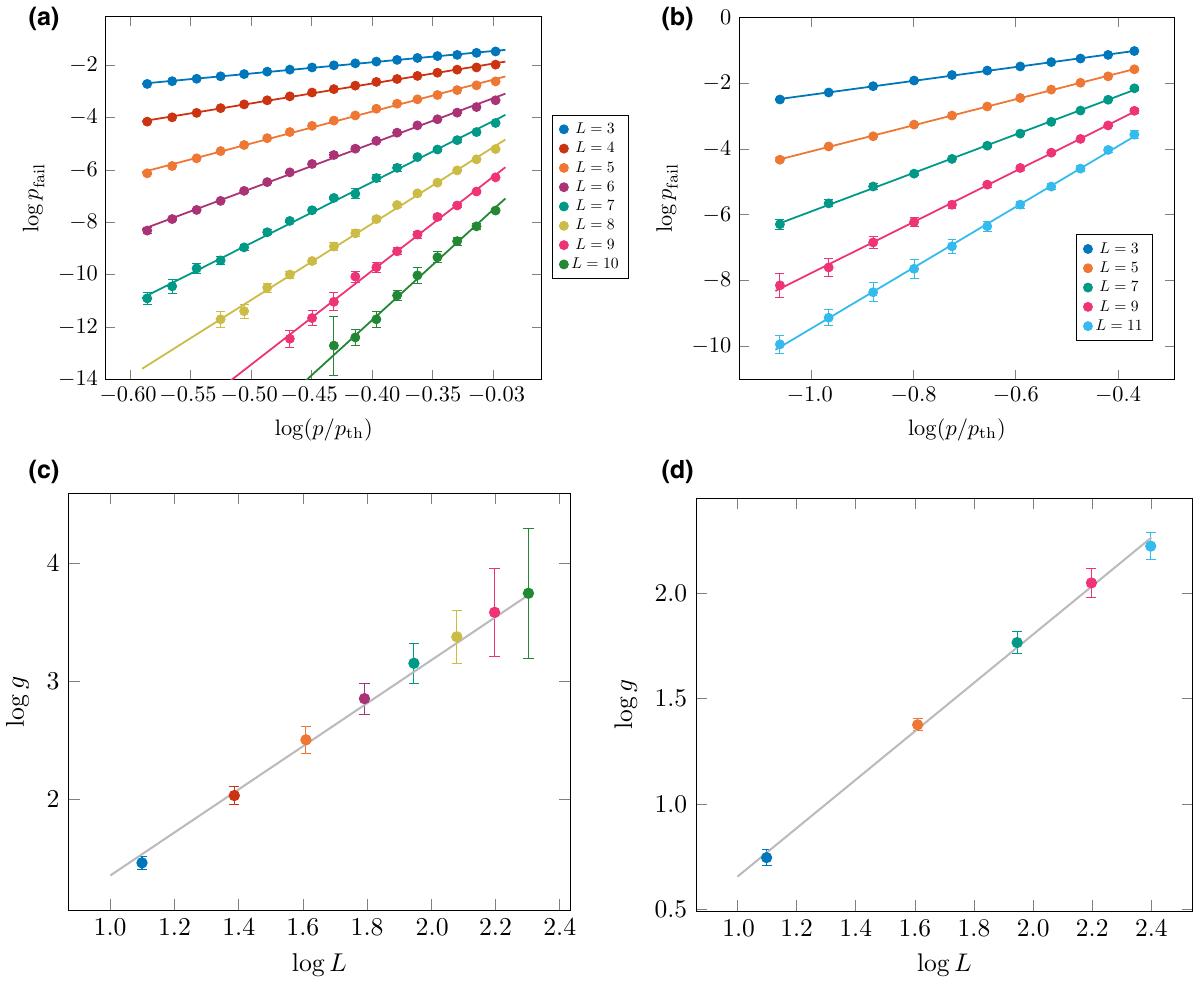
FIG. 10. Illustration of the fitting procedure for finding the coefficients describing the suppression of the logical error rate for phase- flip error rates substantially below threshold. (a),(c) Data for code-capacity noise (no measurement errors), and (b),(d) show data for eight rounds of single-shot error correction. In both cases, we first plot log p fail as a function of log ( p / p th ) for differing values of L , observing trends that agree with the straight line prediction of Eq. (E3) [(a),(b)]. We note that for the single-shot case there is an odd-even effect so we include only the data for odd L . We extract the gradients g ( L ) from the corresponding straight line fits in (a),(b) (gray lines), and plot the logarithms of these values against log L [(c),(d)]. The data fit well to the linear ansatz given in Eq. (E5), which allows us to estimate the parameters α and β , which control the suppression of the logical error rate as per Eq. (E2). For code-capacity noise, we estimate α = 0.546 ( 33 ) and β = 1.91 ( 3 ) , and for eight rounds of single-shot error correction, we estimate α = 0.610 ( 37 ) and β = 1.15 ( 3 ) . The error bars in (a),(b) show the 95% confidence intervals log p is the number of Monte Carlo trials. We include data points with at least 25 failures. The error bars in (c),(d) show the 95% confidence intervals given by the LINEARMODELFIT function of